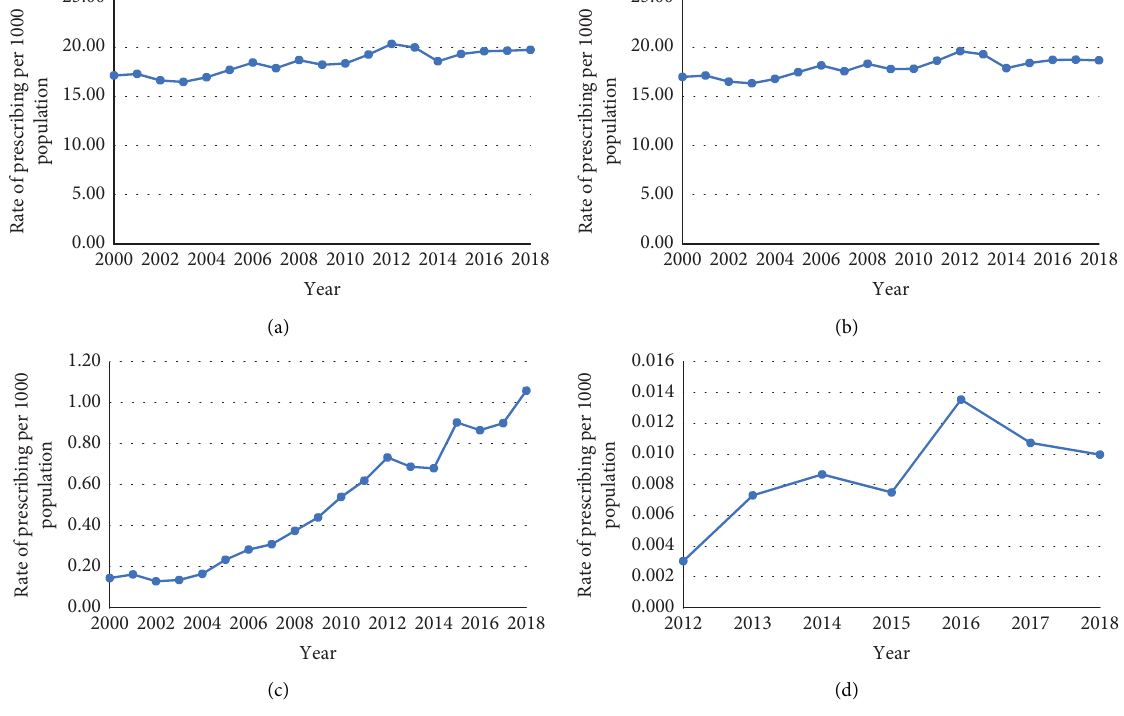
Figure 1: Overall rate of total oral CDI-indicated antibiotic prescribing and by individual antibiotic in British Columbia, 2000–18: (a) shows the rate of total antibiotic prescribing, combining all three antibiotics of interest; (b–d) show the rate of prescribing for metronidazole, vancomycin, and fdaxomicin, respectively, throughout the study